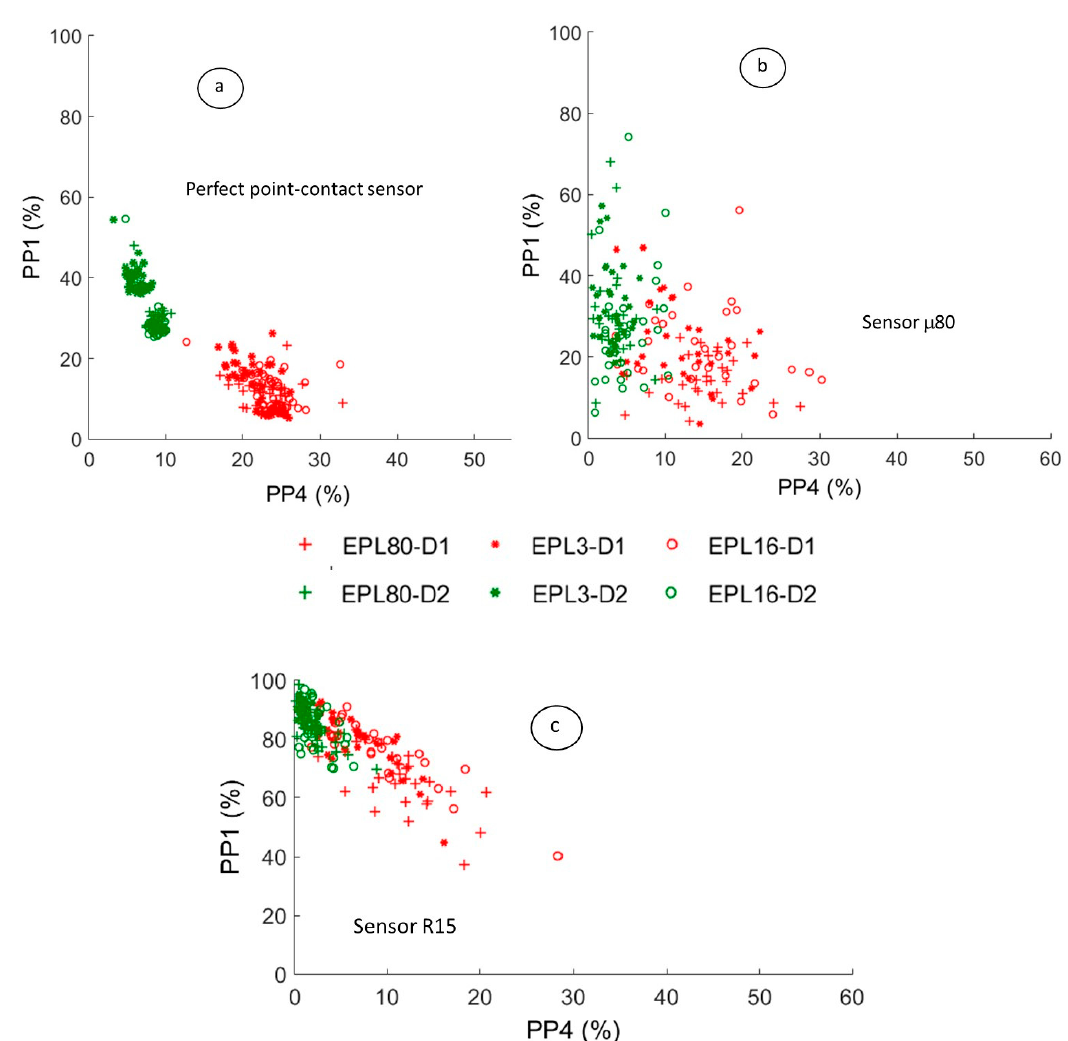
Figure 16. Correlation diagram between PP 1 and PP 4 without sensor effect with a perfect point-contact sensor ( a ), and considering the effect of a μ 80 sensor ( b ) and R15 sensor ( c ).